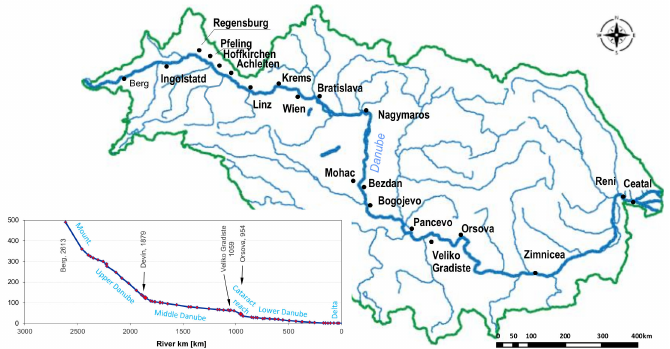
Figure 1. Diagram of the Danube River Basin, water gauging stations along the Danube River, and the six sections of the Danube Basin based on the landscape